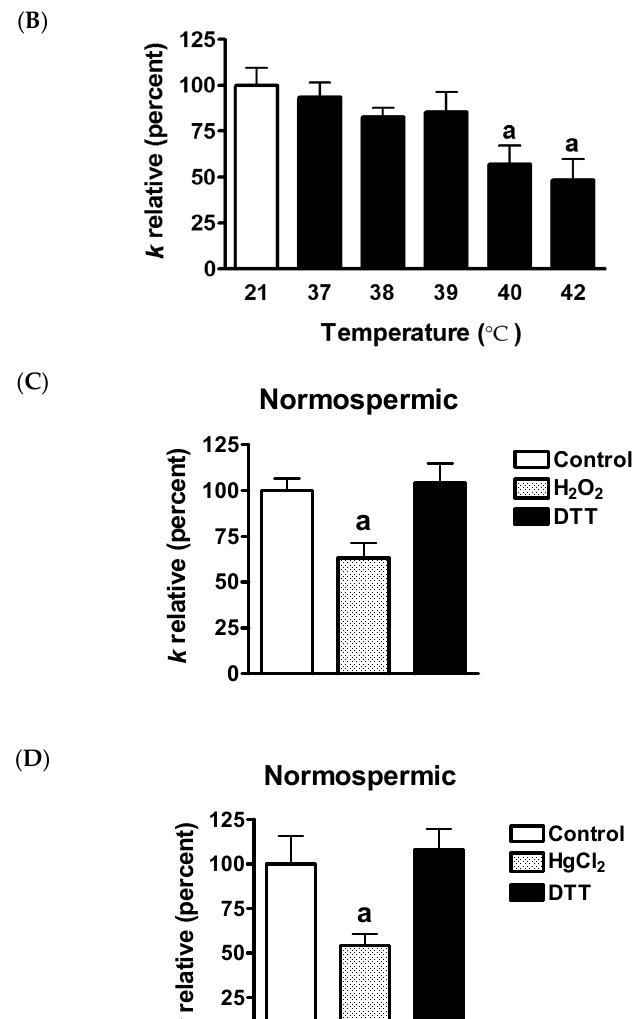
Figure 4. Effect of oxidative stress on the water permeability of human ejaculated semen. ( A ) Effect of hydrogen peroxide (H 2 O 2 ). Sperm cells were exposed to a 150 mOsm osmotic gradient in two different conditions: untreated cells (Control) and cells treated for 45 min with 50 µ M H 2 O 2 to induce an oxidative stress condition. The H 2 O 2 -sensitive water permeability was obtained by subtracting H 2 O 2 insensitive water permeability from total water permeability. a, p < 0.05 vs. normospermic (Student’s t test); b, p < 0.05 vs. Control and c, p < 0.05 vs. H 2 O 2 -sensitive (ANOVA, followed by